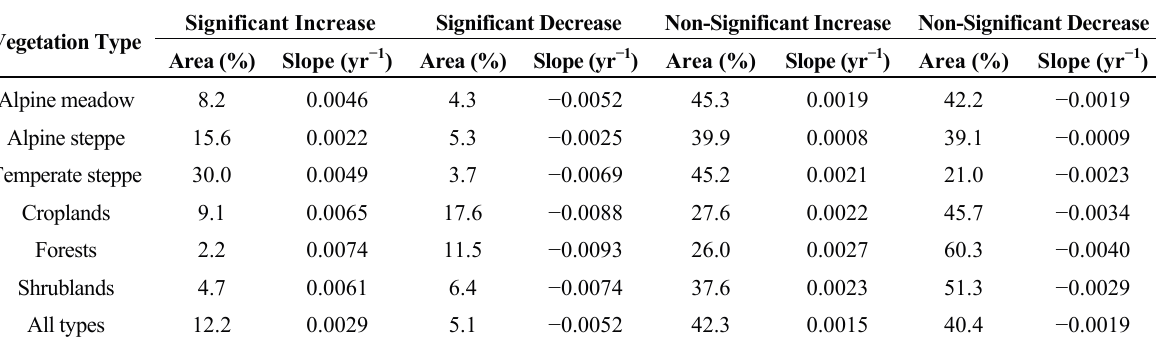
Table 1. Average change magnitude in the growing season maximum enhanced vegetation index from 2000 to 2012 for 81 meteorological stations on the Tibetan Plateau.